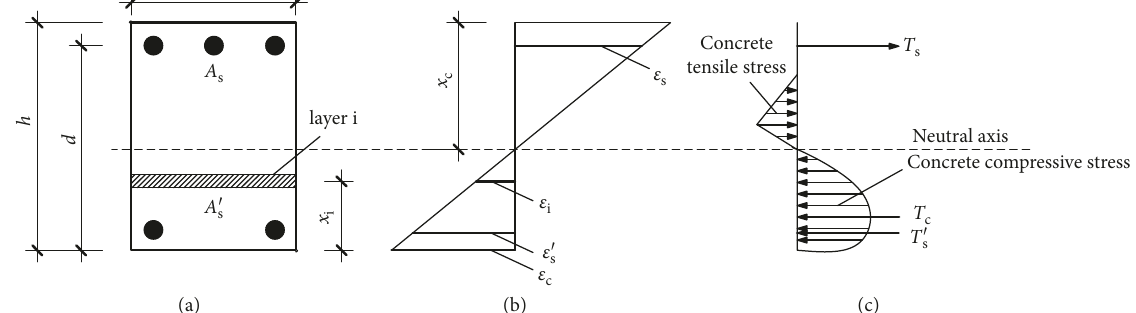
Figure 14: Force equilibrium of the reinforced concrete section. (a) Critical cross section. (b) Strain distribution. (c) Stress distribution.